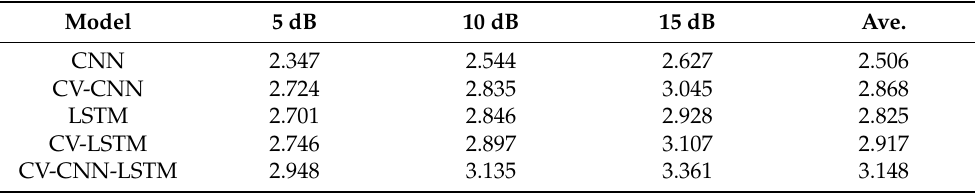
Table 1. The PESQ scores of different models at different SNRs.